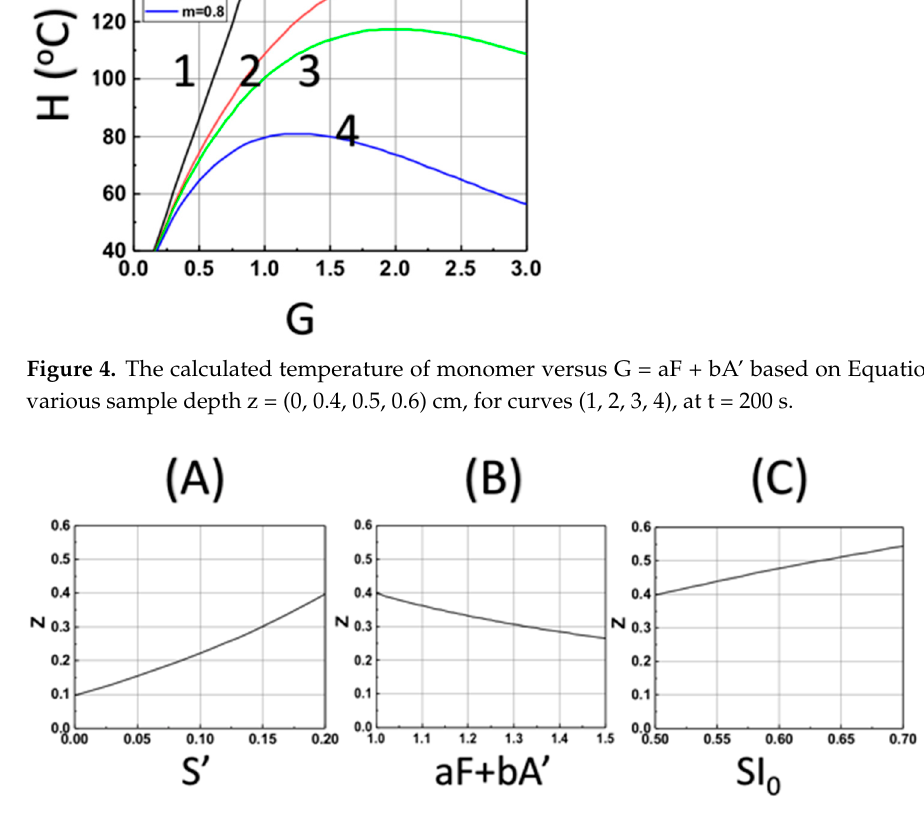
Figure 5. The calculated DoC (Zc) based on Equation (19) for various parameters: ( A ) for Zc vs. S’ with fixed SI 0 = 0.7, aF + bA’ = 1.0 and C* = 0.4; ( B ) for Zc vs. aF + bA’, with fixed SI 0 = 0.5 and S’ = 0.5; ( C ) for Zc vs. SI 0 = 0.5, with fixed and S’ = 0.2 and aF + bA’ =